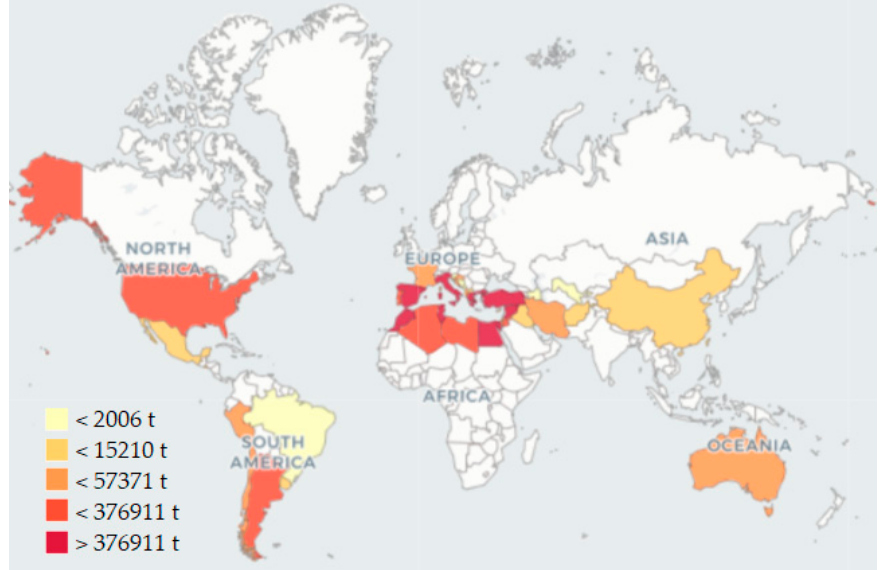
Figure 2. Average production of olives by country between 1994 and 2017. Reproduced with permission from FAOSTAT and OpenStreetMap Foundation [5].